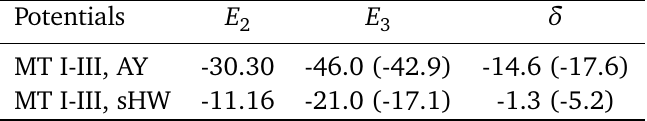
Table 1: Ground state energies E of the NN ¯ K system with the AY and sHW potentials 3 for the N ¯ K interactions and the MT I-III potential [ 19 ] for the NN interaction. The = 0 are given in parenthesis. The difference δ of the two- results for the case V NN − E body 2 E and three-body E energies, δ = 2 E , is presented. The energies are 2 3 2 3 given in